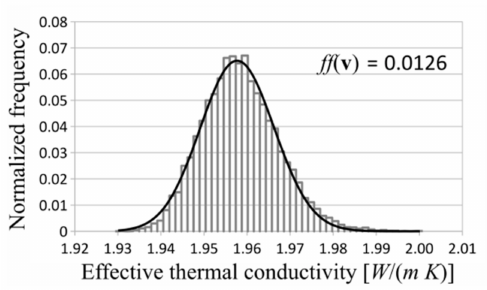
Figure 7. Histogram and log-normal distribution.